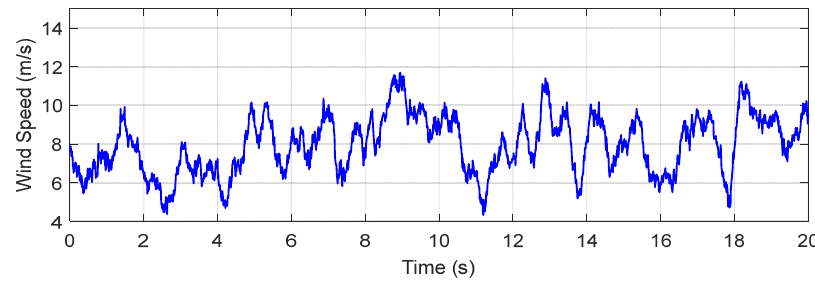
Figure 10. Variable wind speed curve.